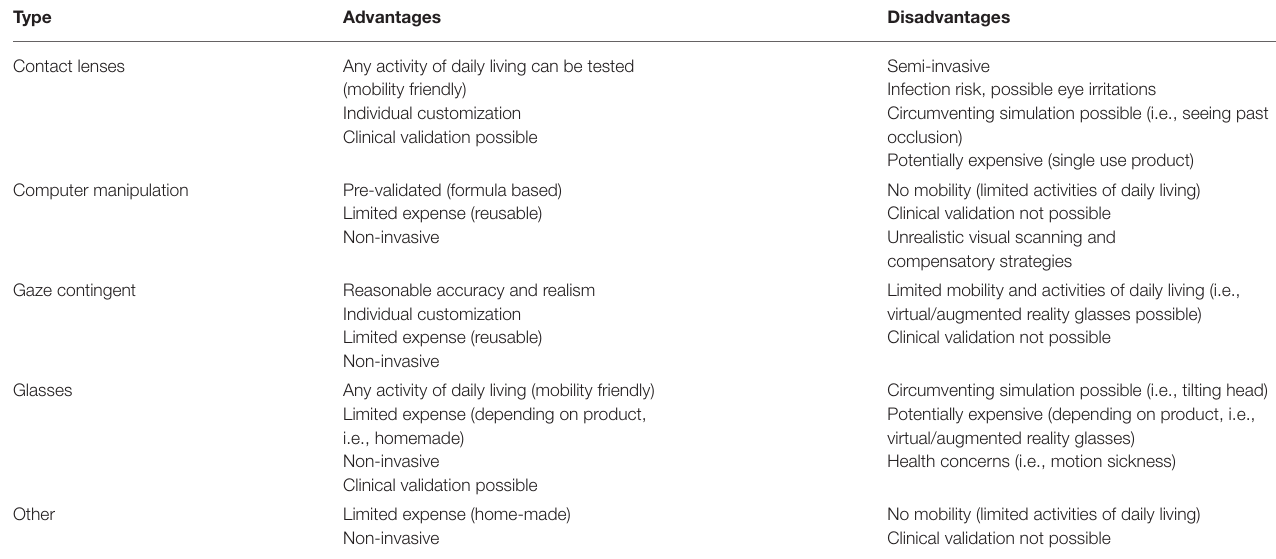
TABLE 3 | Advantages and disadvantages of simulation